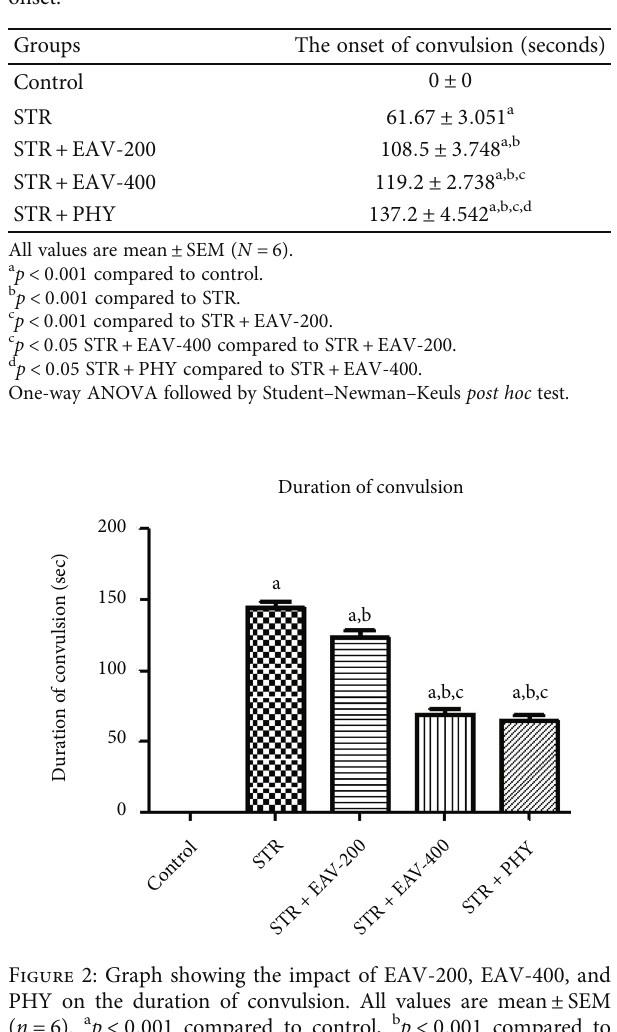
Table 3: E ff ect of EAV-200, EAV-400, and PHY on mortality rate and percentage protection.